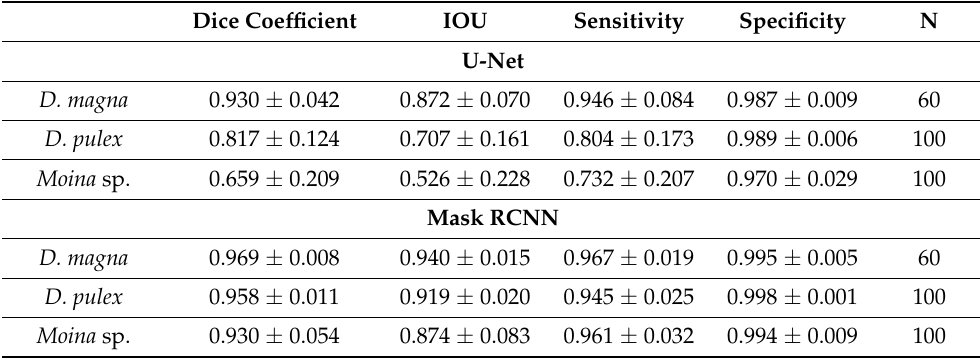
Table 2. Comparison of prediction power of U-Net and Mask RCNN for cardiac size prediction in different water flea species.